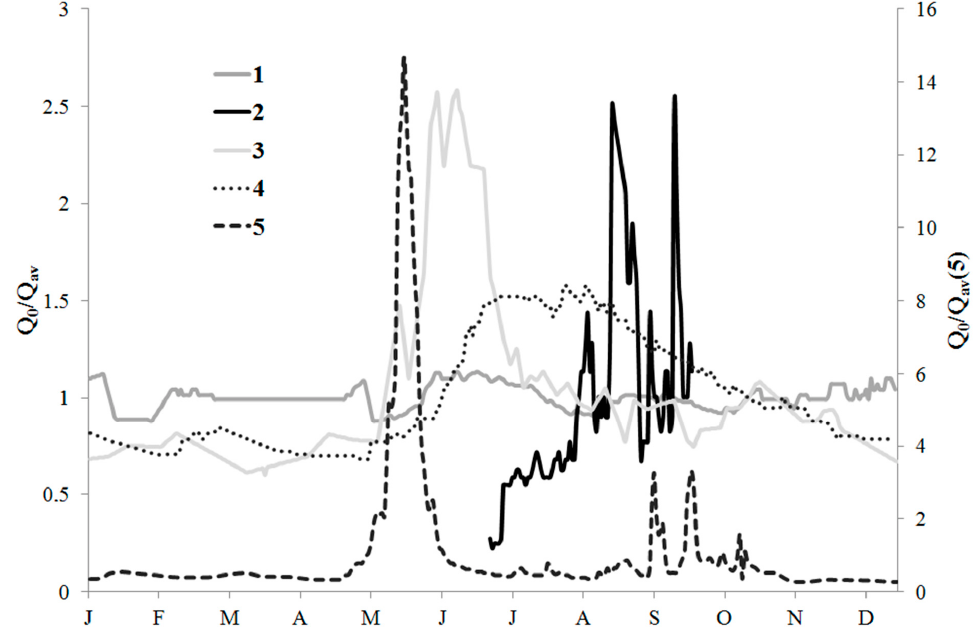
Figure 6. Relative variability of water discharges in rivers with azonal types of water regime. 1—the Nikolka Pervaya River, 2—the Kozel’sky River, 3—the Goryachaya River, 4—the Kronotckaya River, 5—the Bryumka